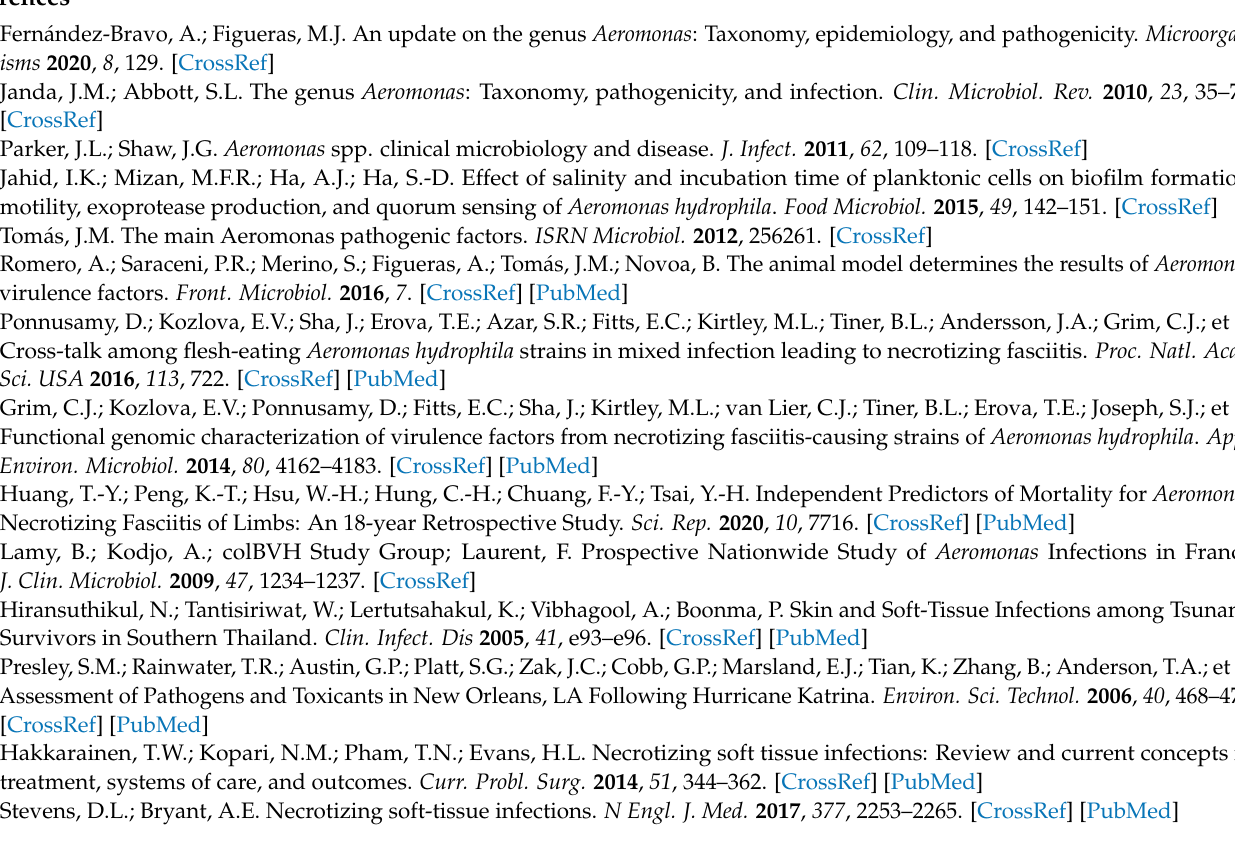
Figure S2: Protein sequence of MotB were aligned by manually PRALINE program, Figure S3: Protein sequence of PomA were aligned by manually PRALINE program, Figure S4: Protein sequence of PomB were aligned by manually PRALINE